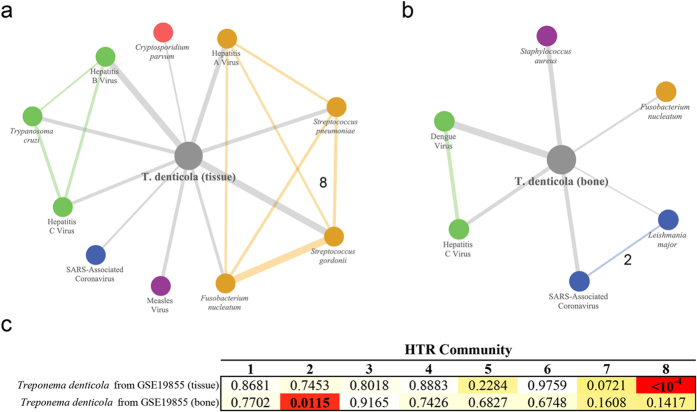
Oral commensal bacterium HTR associations.Subcommunities connected to the external bacterium T. denticola, whose infection HTR was derived from (a) soft tissues overlying calvarial bones and (b) calvarial bones when T. denticola was integrated in each HTR community. (c) Permutation P values for associations between external pathogen signatures and each HTR community. Grey magnified nodes represent query signatures generated from host transcriptional expression profiles (detailed information is provided in Supplementary Table S6). For clarity, we included only pathogen pairs with association scores > 0.5, and permutation P-values < 0.05 are shown in bold. Edge thicknesses are proportional to association scores; edge and node colors are consistent with Figs 3, 5 and 6. Association scores between the external query signatures and the mPRLs are reported in Supplementary Data S8.